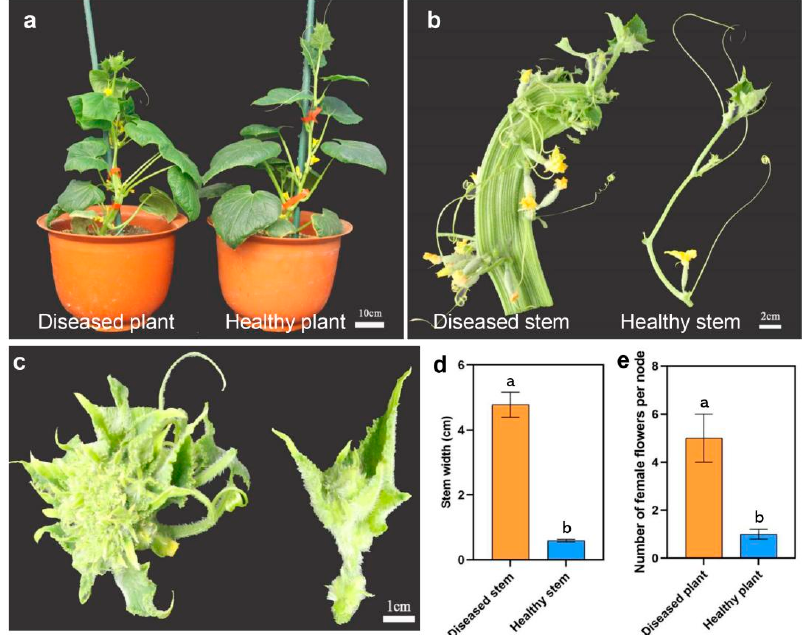
Figure 1. Diseased and healthy cucumber plants in spring 2021: ( a ) whole plants; ( b ) stems; ( c ) growth points; ( d ) stem width of the diseased and healthy cucumber plants; ( e ) number of female flowers of the diseased and healthy cucumber plants. Significance was determined by Duncan’s test ( p < 0.05).